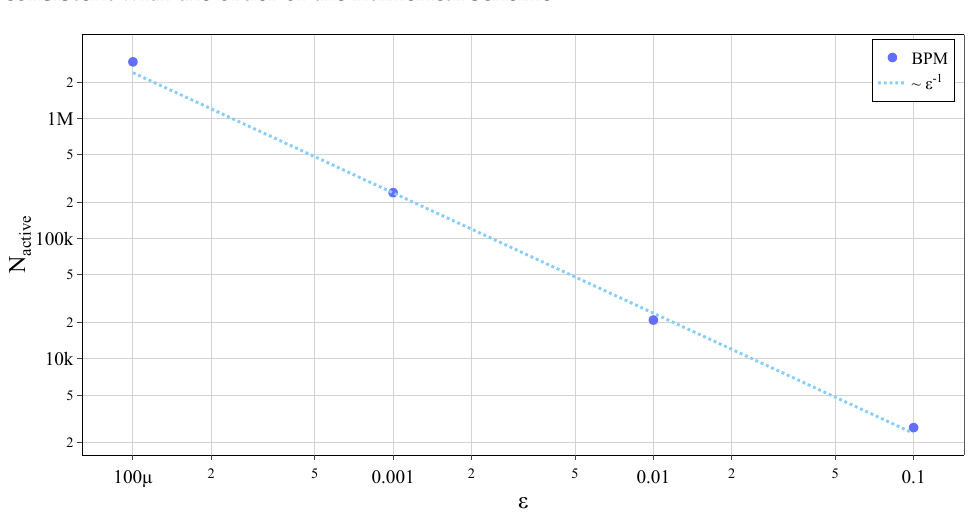
Figure 7. The log-log plot of the number of active cells N active depending on the relative adaptation threshold ε at time t = 0.3. The dependence is well approximated by N active ∝ ε − 1 consistent with the estimate N active ∝ ε − n / s [91] if one takes the order of the scheme s = 2 (the dimension of the problem is n =